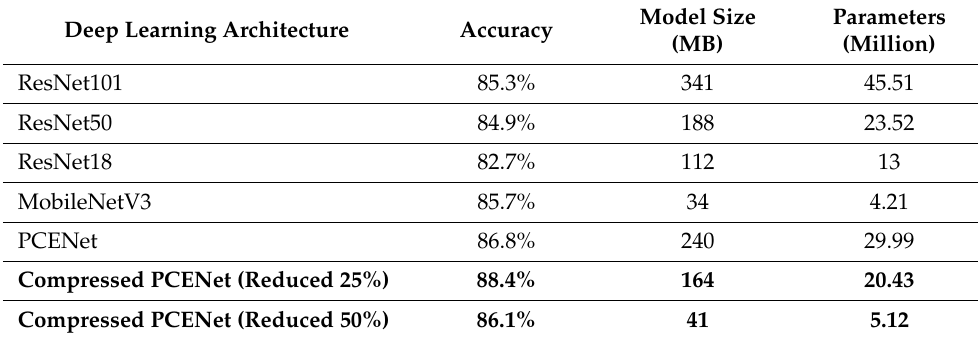
Table 3. Greater compression rate on